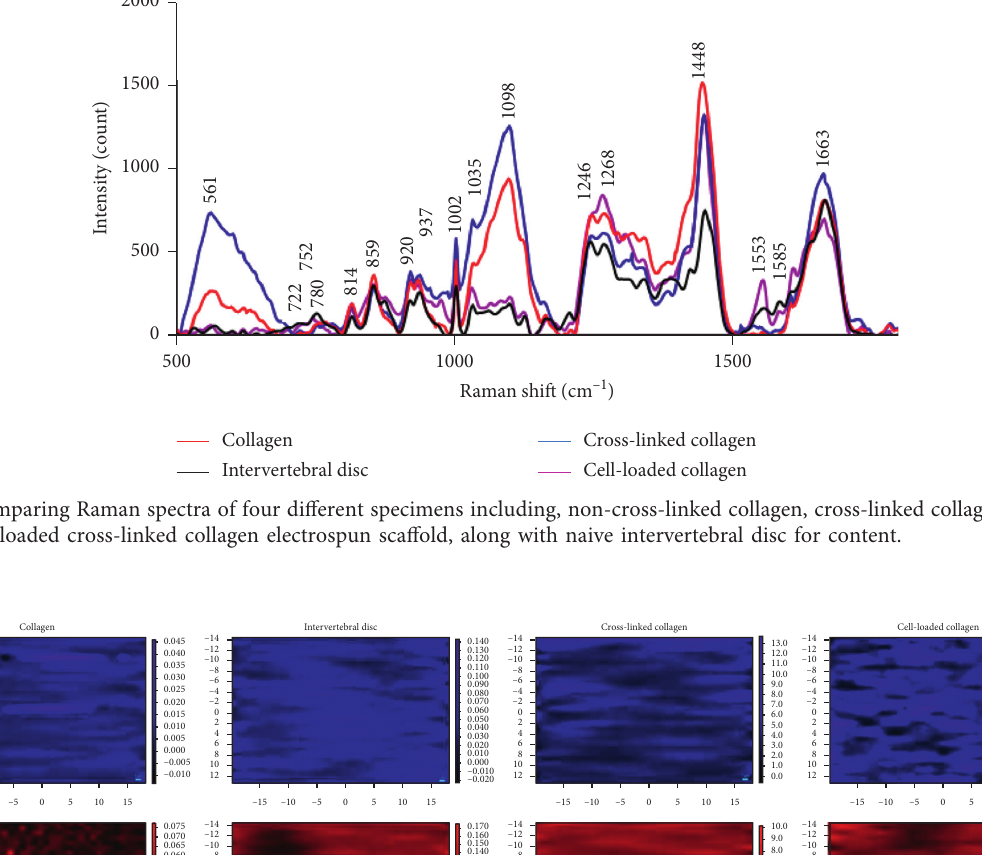
Figure 8: Raman confocal maps of four different specimens showed the distribution of glycosaminoglycans (blue) and hydroxyproline (red). The images display close distribution of glycosaminoglycans and hydroxyproline at 856cm − 1 and 1062cm − 1 , respectively, in cell- loaded cross-linked collagen electrospun scaffold and naive intervertebral